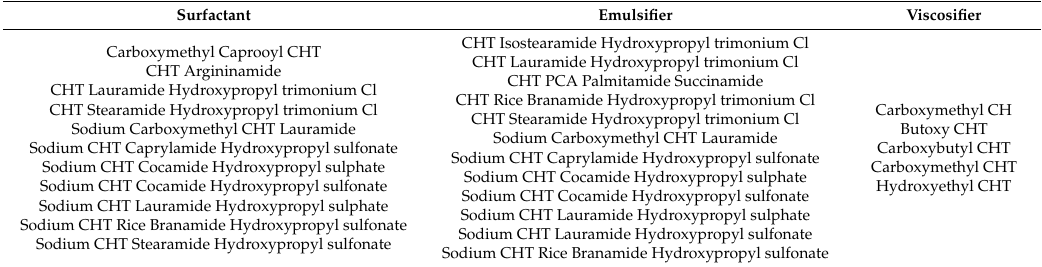
CHT: Chitosan; CH: Chitin.